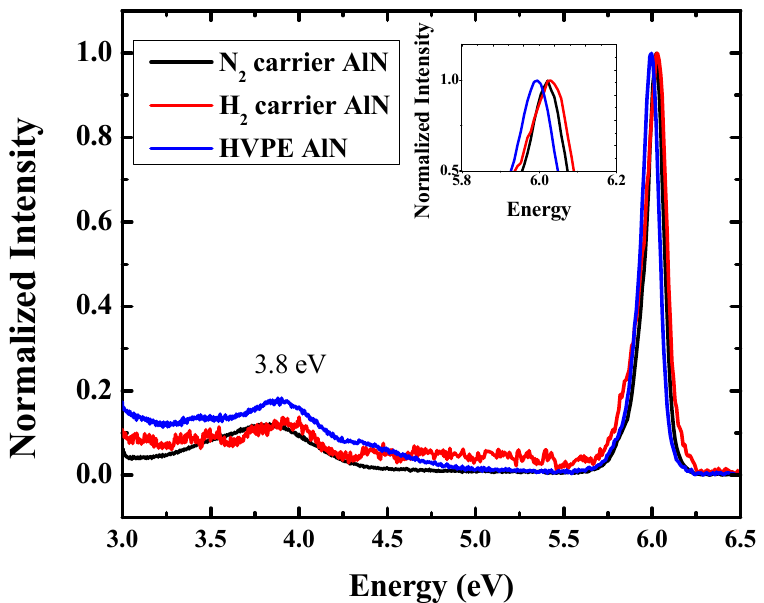
Figure 7. Cathodoluminescence (CL) data for AlN samples grown with N 2 and H 2 carrier gases and HVPE grown free-standing AlN show the near band edge emissions.